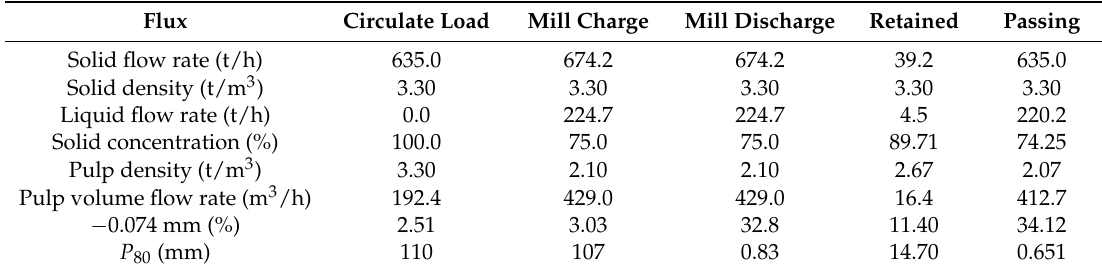
Table 6. Parameters for SAG mill simulation.